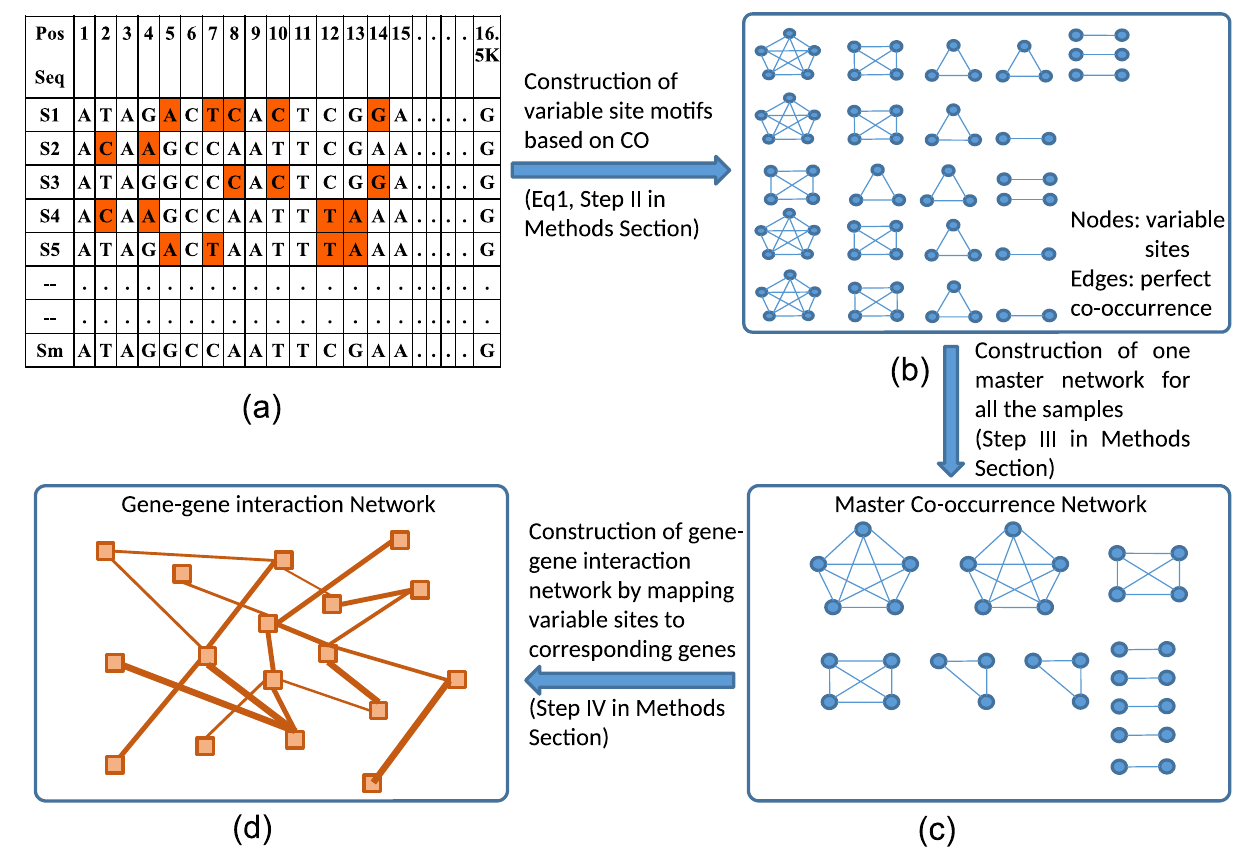
Figure 1. ( a ) Total variable sites are extracted from a particular group and co-occurrence threshold is applied (see “Methods” section). ( b ) For each sample, one set of motifs were constructed. ( c ) These motifs were then merged to construct one master network where nodes were variable sites. ( d ) This master network was then used to construct a gene–gene interaction network by mapping the variable sites corresponding to each gene.